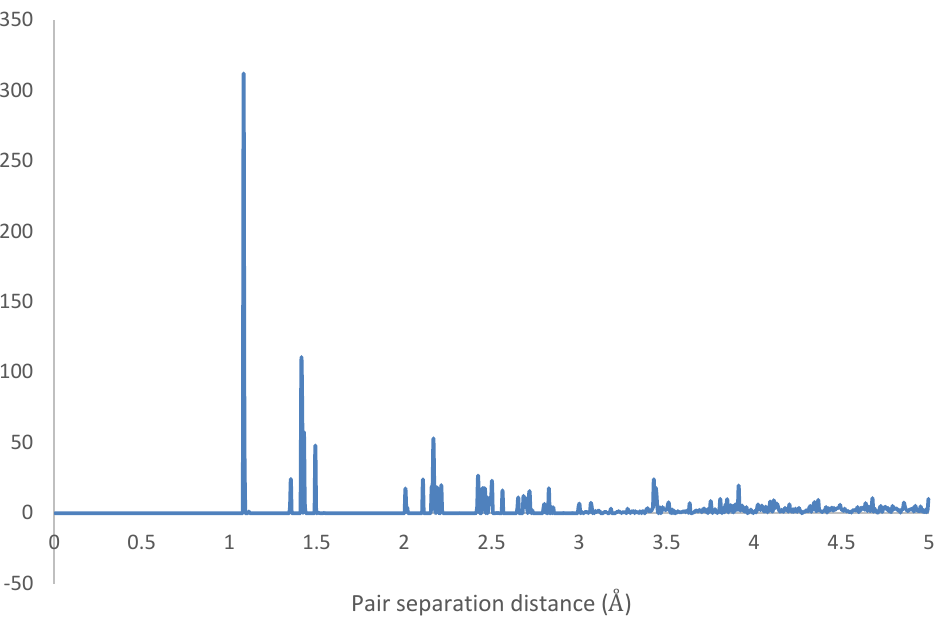
Figure 29. Radial distribution function (RDF) of HB-4PPV with carbon nanotube CNT (initial).